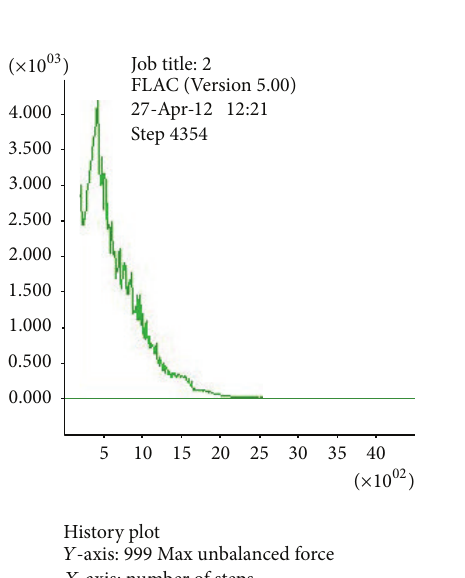
Figure 8: Damage state of rock slope.